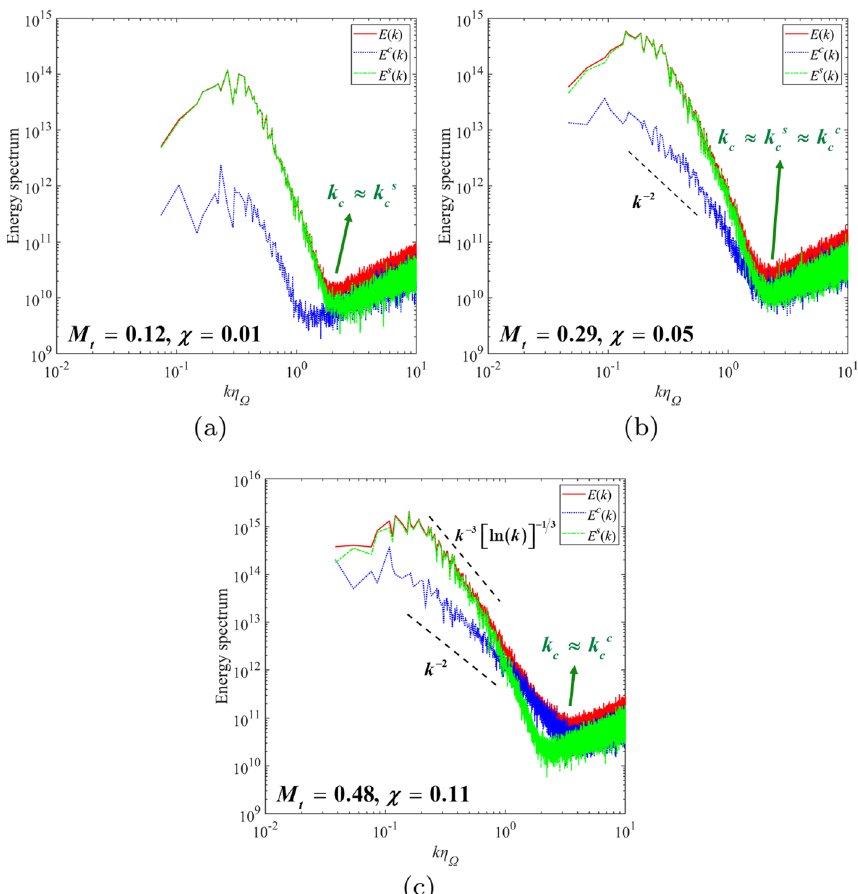
3 , for the case (a) E, (b) F and (c) =